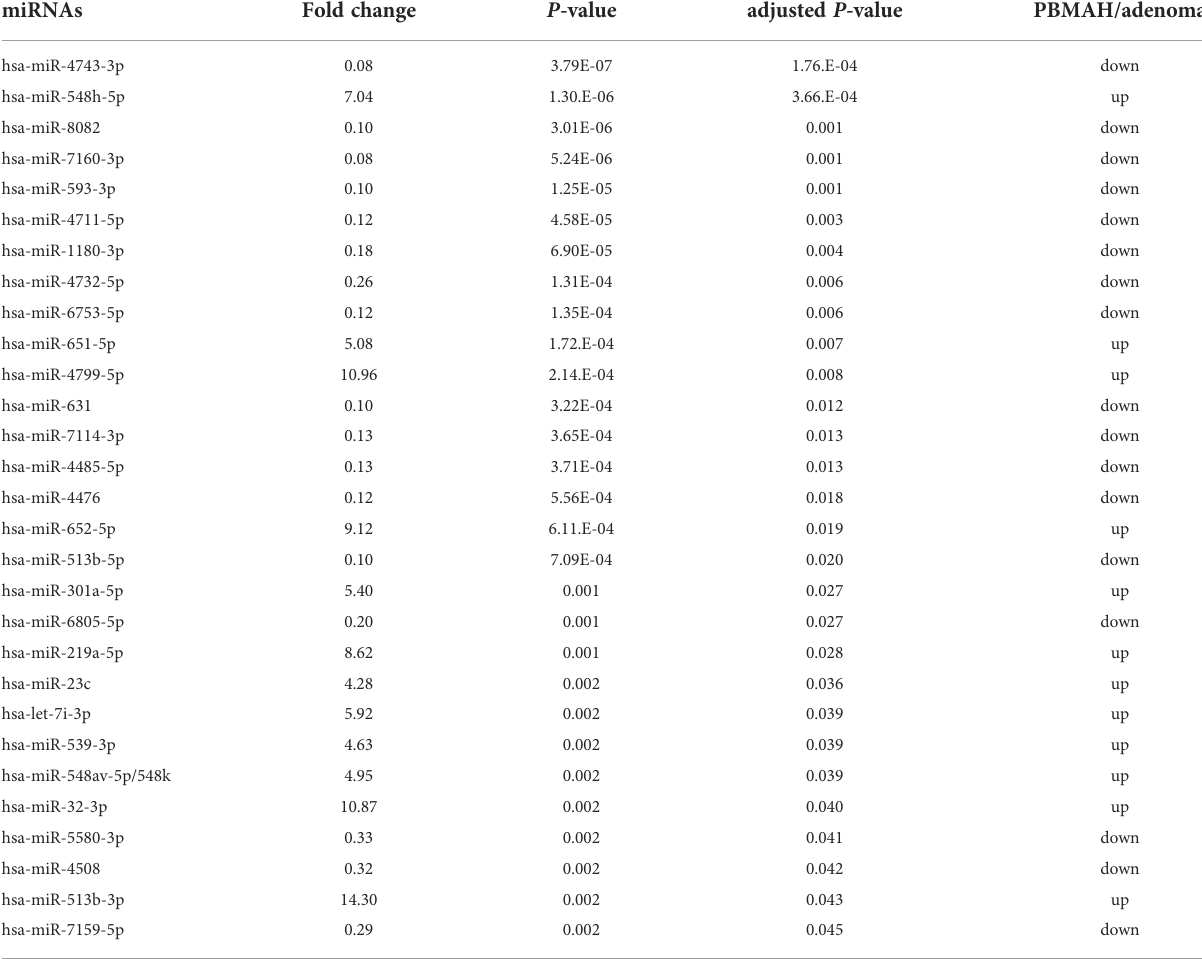
TABLE 3 miRNAs with signi fi cantly different expression (adjusted p < 0.05) between PBMAH and adenoma.